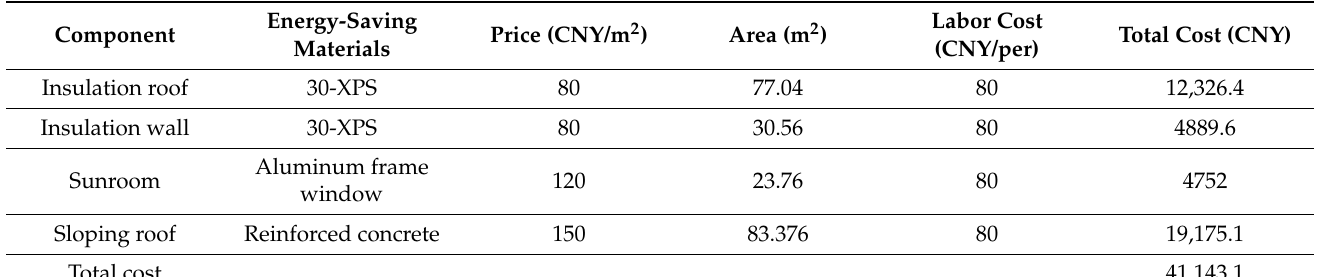
Table 5. Energy-saving renovation